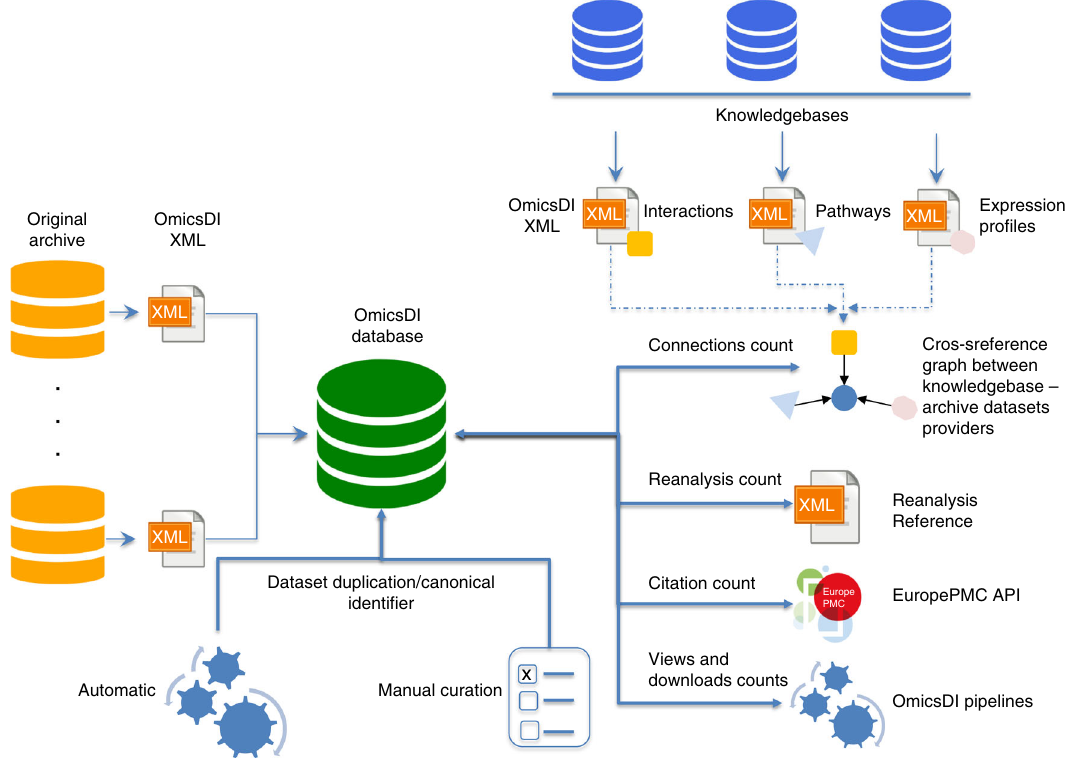
Fig. 5 The metrics estimation pipeline is based on the OmicsDI XML fi le format that is used to transfer datasets from each provider into OmicsDI. Data is imported from each provider into a central MongoDB database. An automatic pipeline is run to detect duplication and data replication across the resource. The pipelines use the central MongoDB database, the EuropePMC API and the knowledgebases (e.g. Ensembl, UniProt) to compute/estimate the different